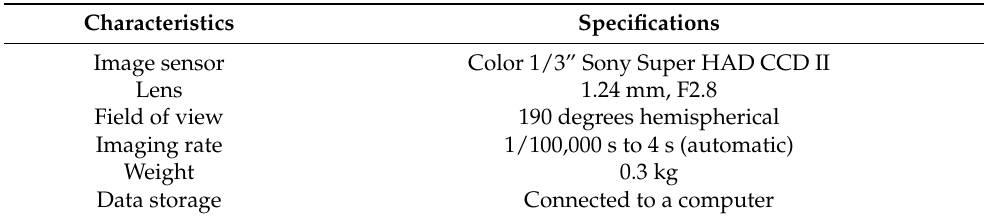
Figure 1. ( a ) An image of the PERMATApintar Observatory and ( b ) an enlarged image of the all-sky imager next to the observatory. Table 1. The specifications of the all-sky imager [21].